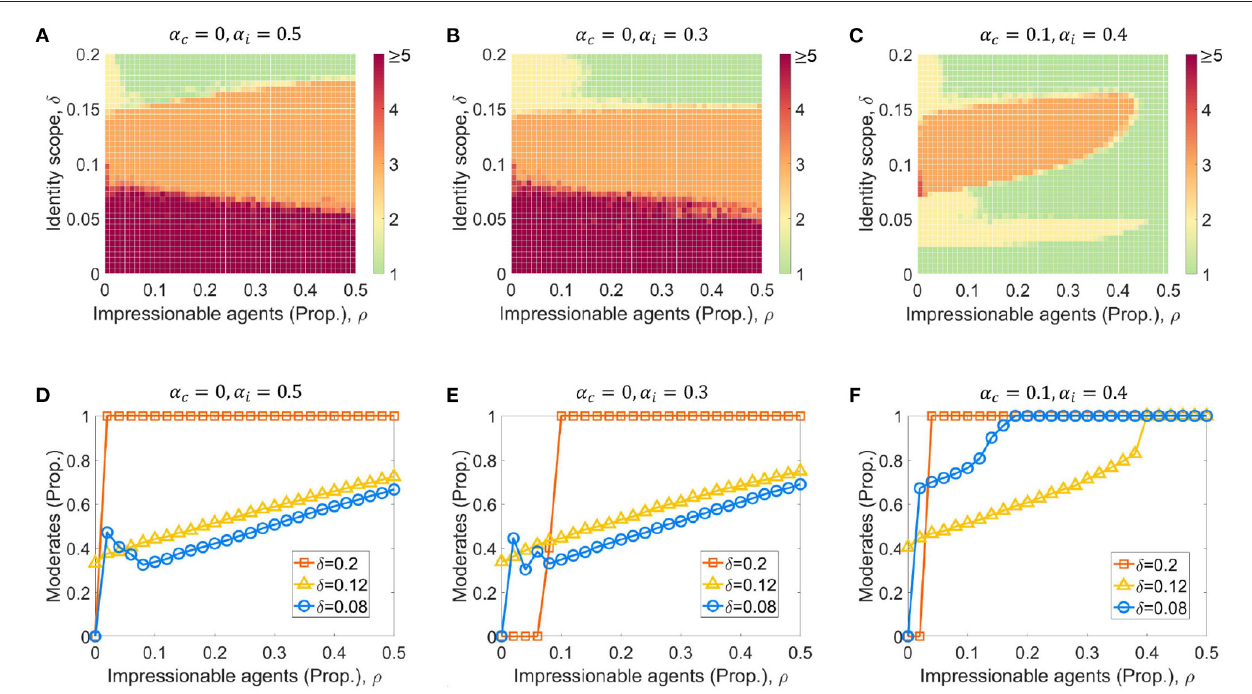
FIGURE 4 | How impressionable individuals affect public opinions. We consider three combinations of α c and α i : (A,D) α c = 0, α i = 0.5, (B,E) α c = 0, α i = 0.3, (C,F) α c = 0.1, α i = 0.4. (A–C) Shown are phase diagrams for the number of opinion clusters under different combinations of identity scope ( δ ) and the proportion of impressionable individuals ( ρ ). (D–F) Shown are the proportion of moderates with respect to changes in ρ under different values of δ . For cases α c = 0, small ρ (more than 0.08) could promote public consensus when δ is relatively large, while it could only increase the proportion of moderates slightly when δ is relatively small. For the case α c = 0.1, small ρ could also lead to public consensus when δ is small enough. Parameters: µ 1 = 0.7, µ 2 =